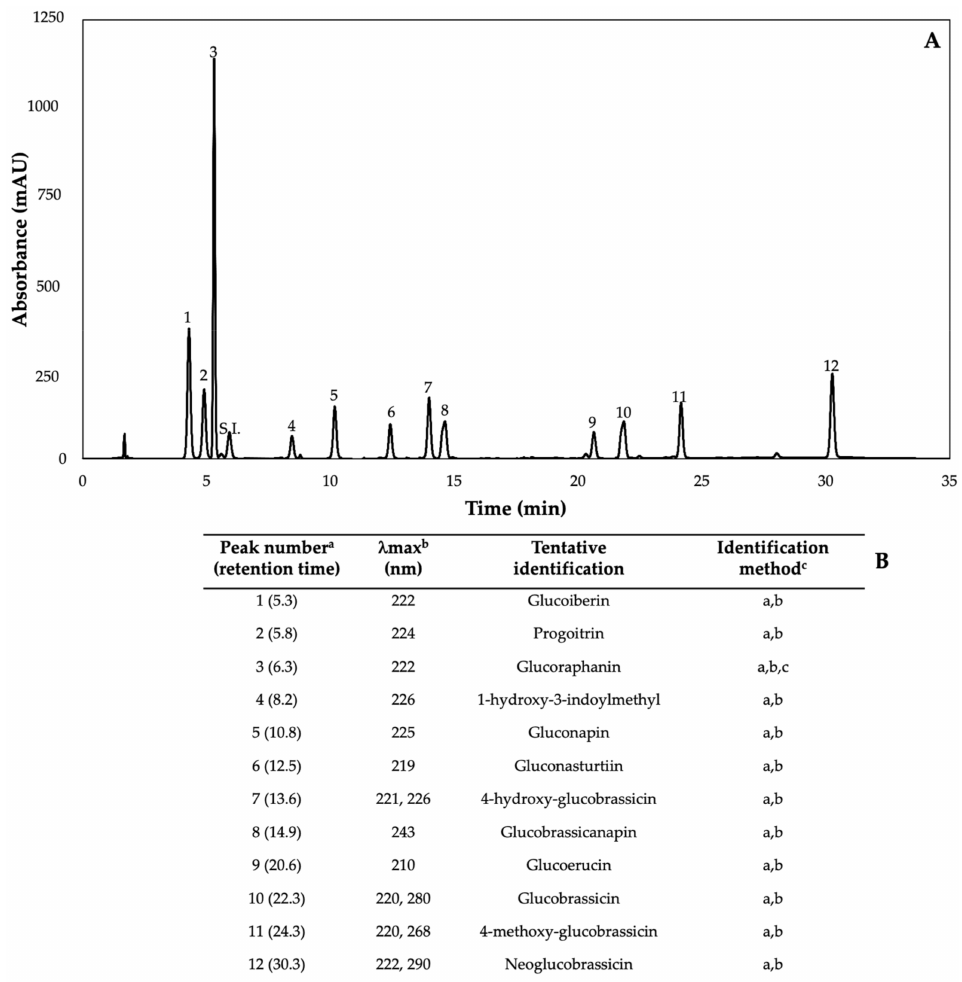
Figure 2. ( A ) HPLC-DAD chromatogram, shown at 227 nm of identified glucosinolates from ethanol/water (70:30, v / v ) extracts of 7-day-old control (water) kale sprouts. ( B ) Tentative identifi- cation of individual glucosinolates in kale sprouts was obtained by HPLC-DAD. a Number of peak assigned according to the order of elution from the C 18 reverse phase. b Wavelengths of maximum absorption in the UV/Vis spectra of each chromatographic peak. c Methods considered for identifi- cation of each chromatographic peak: (a) Identification by comparison of UV–Visible spectra and wavelengths of maximum absorbance reported in prior literature; (b) Identification by comparison with the order of chromatographic elution reported by previous authors [32,42–46]; (c) Identification by comparison with the retention time and UV–Visible spectra of authentical